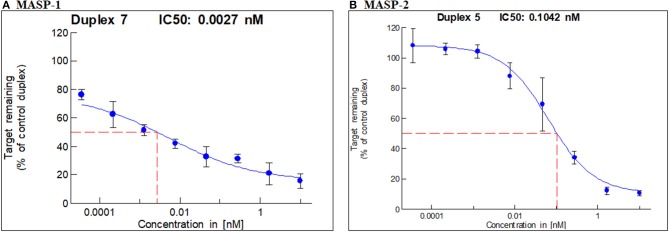
IC50 for MASP-1 and MASP-2 silencing with GalNAc-MASP1 or GalNAc-MASP-2 siRNAs: A Dual-Glo luciferase assay was performed using COS7 cells expressing individually Firefly Luciferase-MASP1 or MASP2 fusion constructs. COS7 cells were transfected with mouse MASP-1 or mouse MASP-2 specific siRNAs at the concentrations indicated. Luminescence levels were measured at 48 hrs post transfection with siRNAs. The ratio of normalized luminescence was plotted in MS Excel to calculate the IC50 for MASP-1 and MASP-2 duplexes— (A) MASP-1 duplex IC50 = 0.0027 nM, (B) MASP-2 duplex IC50 = 0.1042 nM.